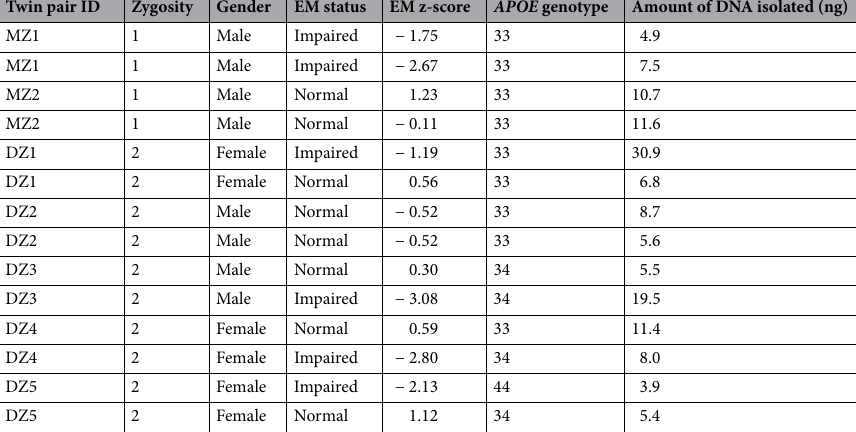
Table 1. Description of the seven Finnish twin pairs included in the plasma cell-free DNA methylation analysis. Their mean age was 74.1 years (range 73–76). Zygosity (1: monozygotic, 2: dizygotic), EM episodic